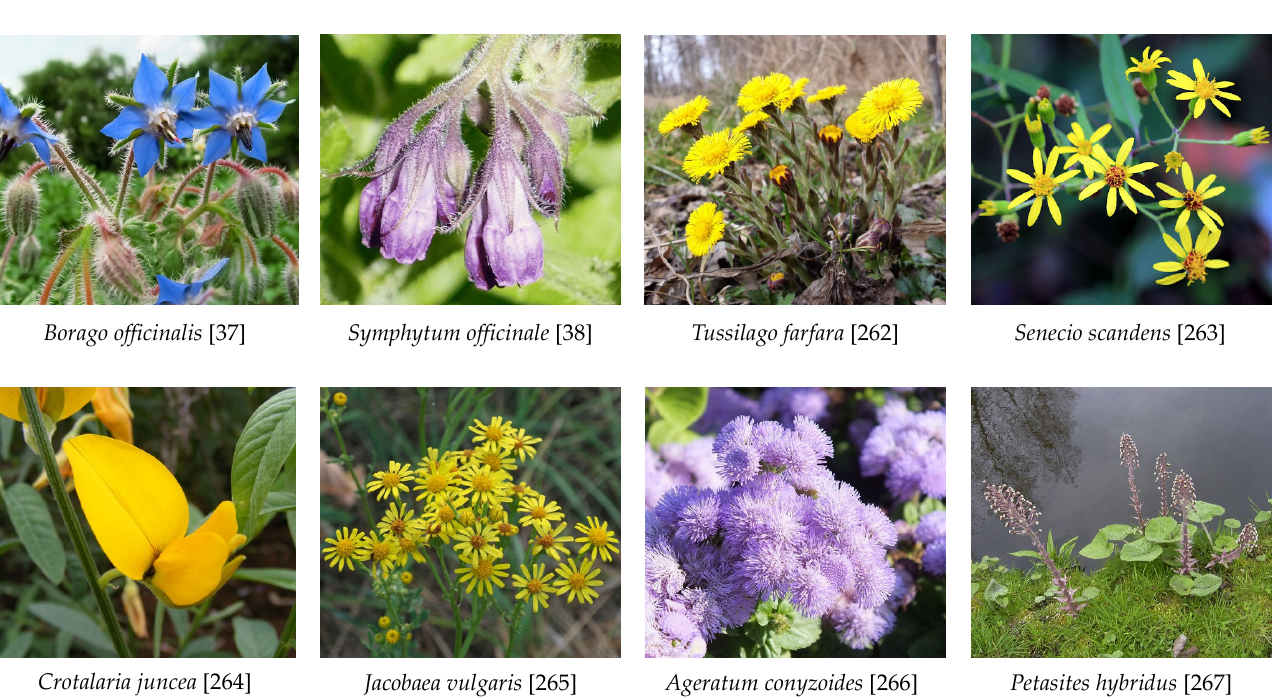
Figure 10. Photography of PA-containing plants. All pictures above show PA-containing plants mentioned in the text of this manuscript and are obtained from open access publications as referenced [37,38,262–267]. Symphytum officinale (syn. Symphytum peregrinum ), Petasites hybridus (syn. Petasites officinalis ), Tussilago farfara (syn. Tussilago alpestris ), and Jacobaea vulgaris (syn. Senecio jacbaea ) are native to Europe. Senecio scandens (syn. Senecio chinensis ) has a native range from China to Indo–China and Central Malesia, meanwhile that of Crotalaria juncea (syn. Crotalaria fenestrate ) is from Afghanistan to Indo-China. Ageratum conyzoides (syn. Ageratum album ) mostly distributes in Tropical America, whereas Borago officinalis (syn. Borago hortensis ) originates from the Mediterranean